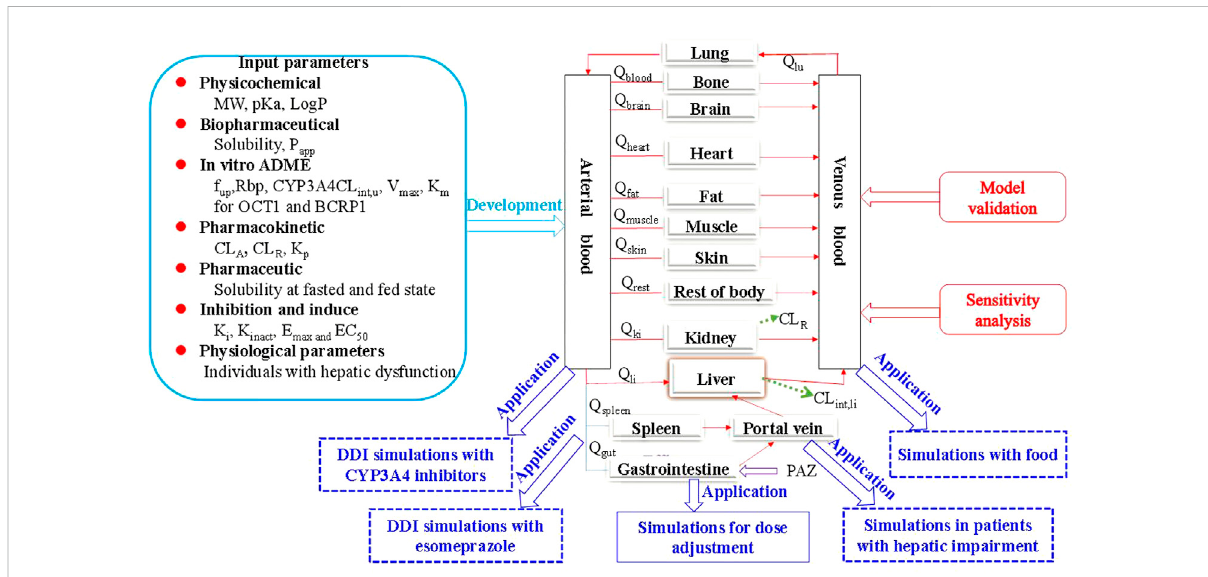
FIGURE 1 The generic work fl ow of the PBPK model for PAZ in human. The PBPK model is connected by blood fl ow rate (Q) and tissue compartments, which involves the gastrointestine, blood (arterial supply and venous return), eliminating tissues (liver and kidney) and non-eliminating tissues (13 compartments in total, such as the lung). The population PBPK model was built based on multiple modeling parameters and virtual population, and validatedusing the three PK pro fi les from the literature ((Deng etal., 2013) and (Heathet al., 2012)) and 11 different dosage regimen PK data sets from the literature ((Hurwitz et al., 2009)). Sensitivity analysis showed the two parameters are the most sensitive to the PBPK model. Subsequently,the PBPKmodel exhibited a wide application in fi ve different aspects involving DDI with thetwo CYP3A4 inhibitorsand with one